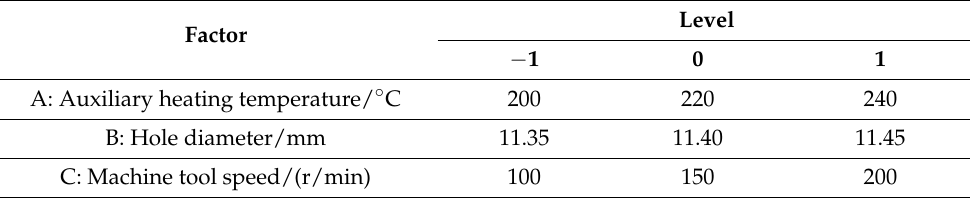
Table 3. Experimental design of three factors and three levels of response surface method. Factor